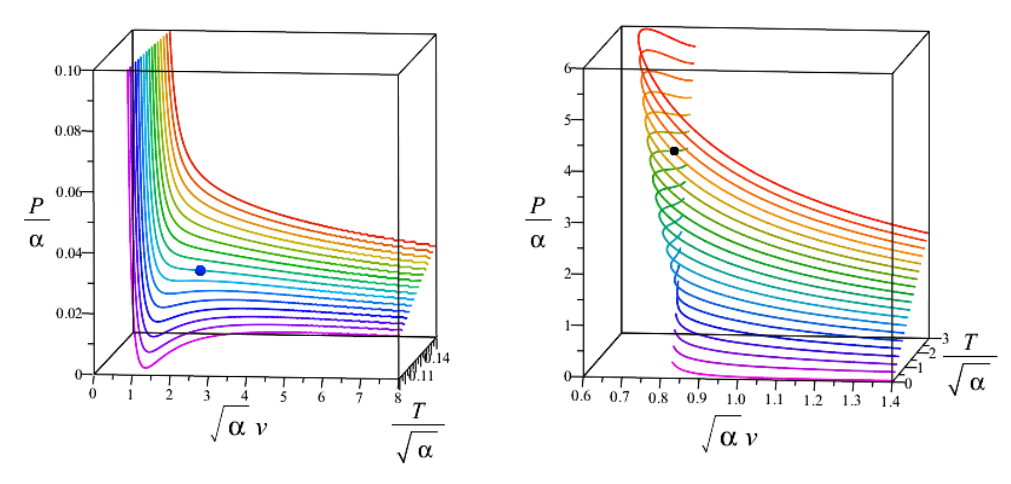
Figure 16 . Equation of state, given (cid:22) Q = 0 : 67. The two plots correspond to di(cid:11)erent regions of the same phase space. Left : in this region, we observe a critical point similar to that in RN-AdS.